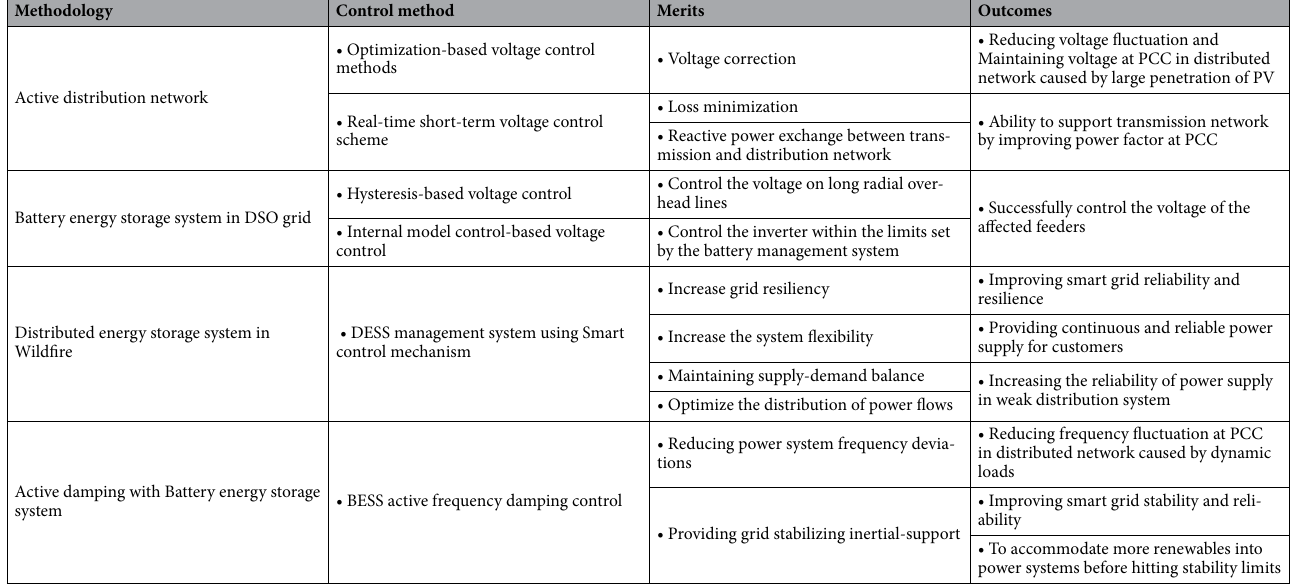
Table 1. Smart grid and energy storage system.